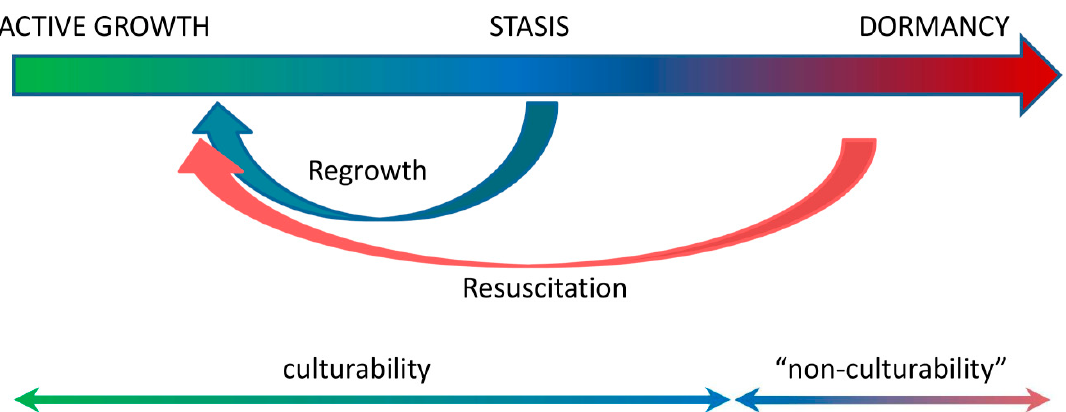
Figure 2. The hypothetical scheme of persisting M. tuberculosis population during latent infection.